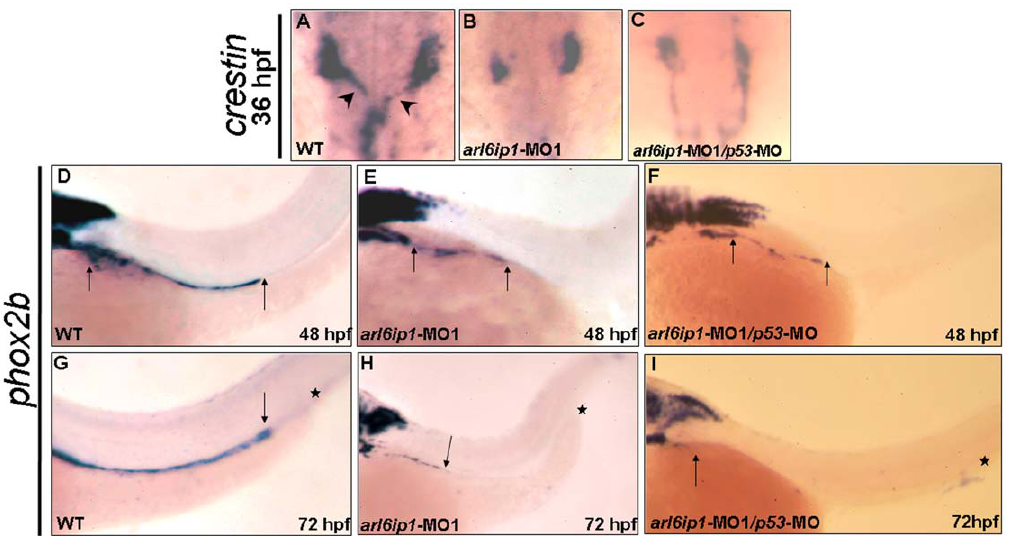
Figure 7. Enteric nervous system of arl6ip1 morphants is degenerated. Wild-type (WT) embryos (A, D, G), arl6ip1 -MO1-injected embryos (B, E, H), and arl6ip1 -MO1/ p53 -MO-injected embryos (C, F, I) were observed under dorsal view at 36-hpf (A–C) and under lateral view at 48 hpf (D, E, F) and 72 hpf (G, H, I). Neural crest cells (NCCs), which were labeled by crestin probe (arrowheads in A), of WT embryos exited the vagal region and migrated to the enteric region. However, the crestin -labeled NCCs of arl6ip1 -MO1-injected and arl6ip1 -MO1/ p53 -MO-injected embryos remained in the vagal region (B, C). Compared to WT embryos, either the arl6ip1 -MO1-injected embryos or arl6ip1 -MO1/ p53 -MO-injected embryos exhibited shortened enteric neurons and delayed migration (D vs. E; D vs. F; distance between two arrows). Additionally, the phox2b -positive enteric neurons were distributed throughout the entire gut to the anus (G). Arrows indicate the most posterior region of migration, and the asterisks represent the anus. The enteric neurons of arl6ip1 -MO1-injected embryos and arl6ip1 -MO1/ p53 -MO-injected embryos all failed to reach as far as the anus (H, I).